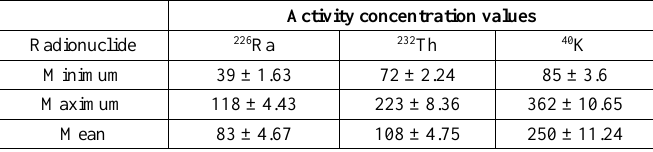
Table 1: Mean and Range of Activity Concentrations of the